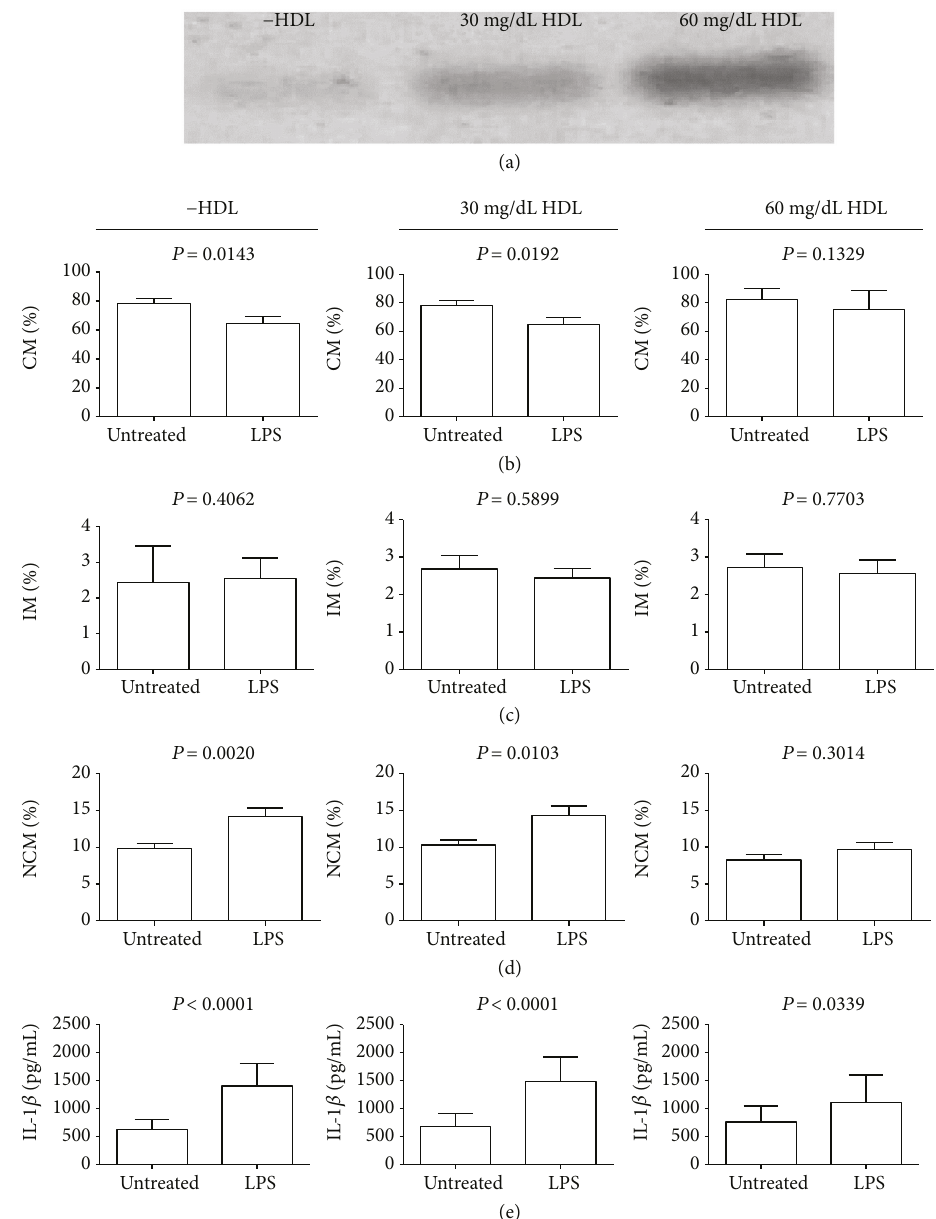
Figure 2: E ff ect of HDL on LPS-stimulated primary human monocytes in vitro . Representative polyacrylamide gel showing a metabolic syndrome patient ’ s serum sample in which HDL was totally removed ( − HDL) and then reconstituted with 0.77mmol/L (30 mg/dL) or 1.55mmol/L (60 mg/dL) HDL (a). As compared to untreated cells, LPS stimulation induced reduction in the CM percentage in low HDL levels (zero and 30mg/dL) (b, left and middle panels, resp.). In contrast, the e ff ect of LPS on the CM percentage was abolished in 60mg/dL HDL that resembled a high HDL concentration (b, right panel). LPS stimulation did not signi fi cantly modify the IM percentage neither in low nor in high HDL concentrations (c, left, middle and right panels, resp.). As compared to untreated cells, LPS stimulation increased the NCM percentage in zero and 30mg/dL HDL (d, left and middle panels, resp.). On the contrary, the e ff ect of LPS on the NCM percentage was abolished in high HDL concentrations (d, right panel). As compared to untreated cells, LPS stimulation increased IL-1 β production in primary human monocytes cultured in low HDL concentrations (e, left and middle panels, resp.). In contrast, the e ff ect of LPS on IL-1 β production was 1.5-fold reduced in 60mg/dL HDL (e, right panel). Monocytes were isolated from white blood cells by CD14-positive selection using magnetic columns and placed in 0.77mmol/L (30 mg/dL) or 1.55mmol/L (60 mg/dL) HDL-enriched culture media (1 × 10 6 monocytes per well), in the presence or absence of gram-negative bacteria-derived LPS at 1 μ g/mL for six hours at 37 ° C. After this time, monocytes were incubated with anti-CD14 PE/Cy7 and anti-CD16 FITC as described. For the gating strategy, untreated and LPS-treated cells were fi rstly gated for singlets on a FSC-H/FSC-A density plot. On the monocyte gate, living untreated and LPS-treated cells were further gated using the Live/Dead Aqua stain. Living monocytes were then gated to determine CD14- and CD16-positive expression and identify monocyte subpopulations as follows: CD14 high CD16 − , classical monocytes; CD14 high CD16 + , intermediate monocytes; and CD14 low CD16 + , nonclassical monocytes. In (b – e), data are expressed as mean ± standard deviation. Signi fi cant di ff erences were considered when P < 0 05